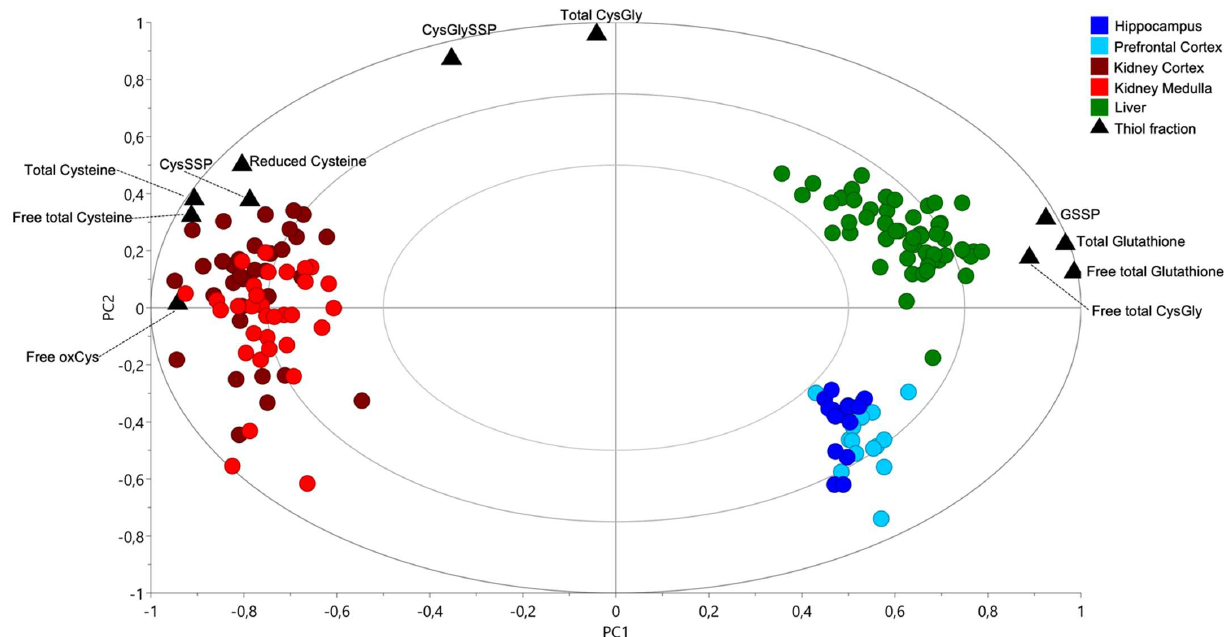
Figure 3. Tissue-specific thiol distribution amongst the organs. Principal Component Analysis with all organs; biplot displaying the plot score and the loadings plot. CysGly: cysteinylglycine; CysGlySSP: cysteinylglycinated proteins; CysSSP: cysteinylated proteins; GSSP: glutathionylated proteins; oxCys: oxidized cysteine; PC: Principal Component.